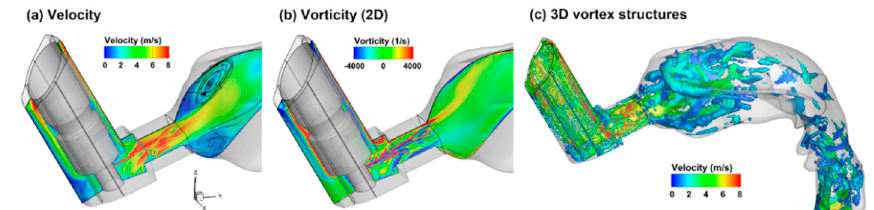
Figure 7. Airflow features inside the MDI and mouth 100 ms after MDI actuation under the inhalation waveform of Qmax = 60 L/min: ( a ) velocity, ( b ) vorticity, and ( c ) 3D vortex structures.